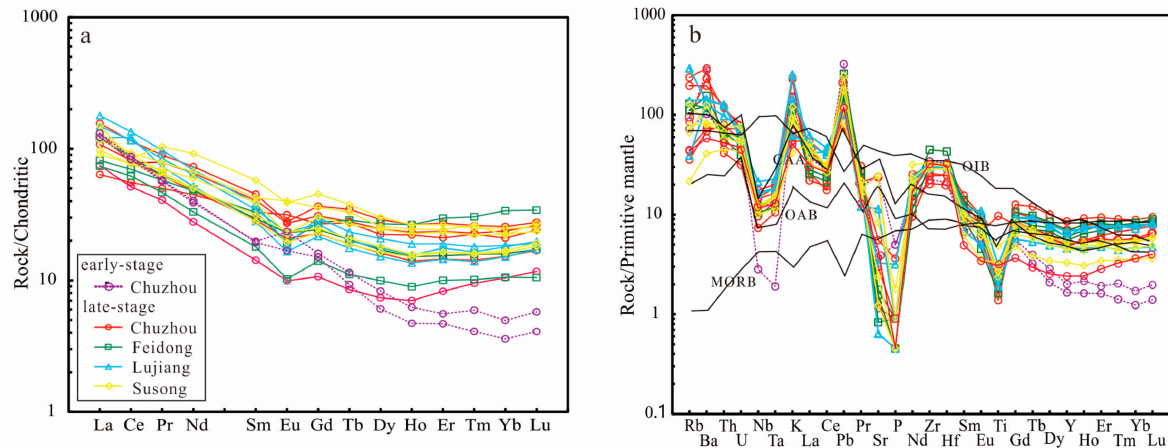
Figure 6. ( a ) Chondrite-normalized rare earth element diagram, and ( b ) primitive mantle-normalized element spider diagram for volcanic rocks of the Xileng Formation. Data of OIB (ocean island basalt), OAB (oceanic arc basalt), CAA (continental arc andesite), and MORB (mid-ocean ridge basalt) after [37]; normalization values from